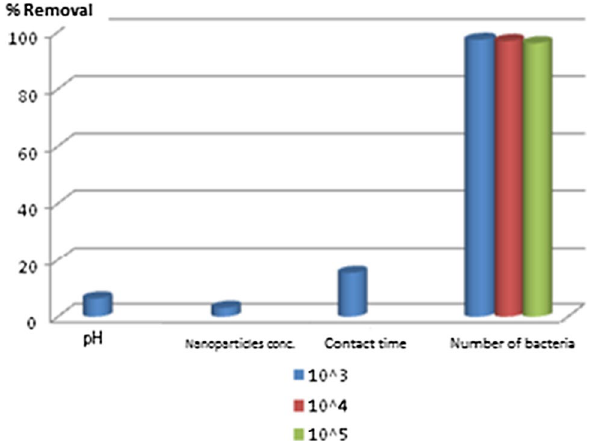
Fig. 5 The effect of the number of bacteria on magnetic nanoparticles disinfection efficiency at optimum point for Escherichia